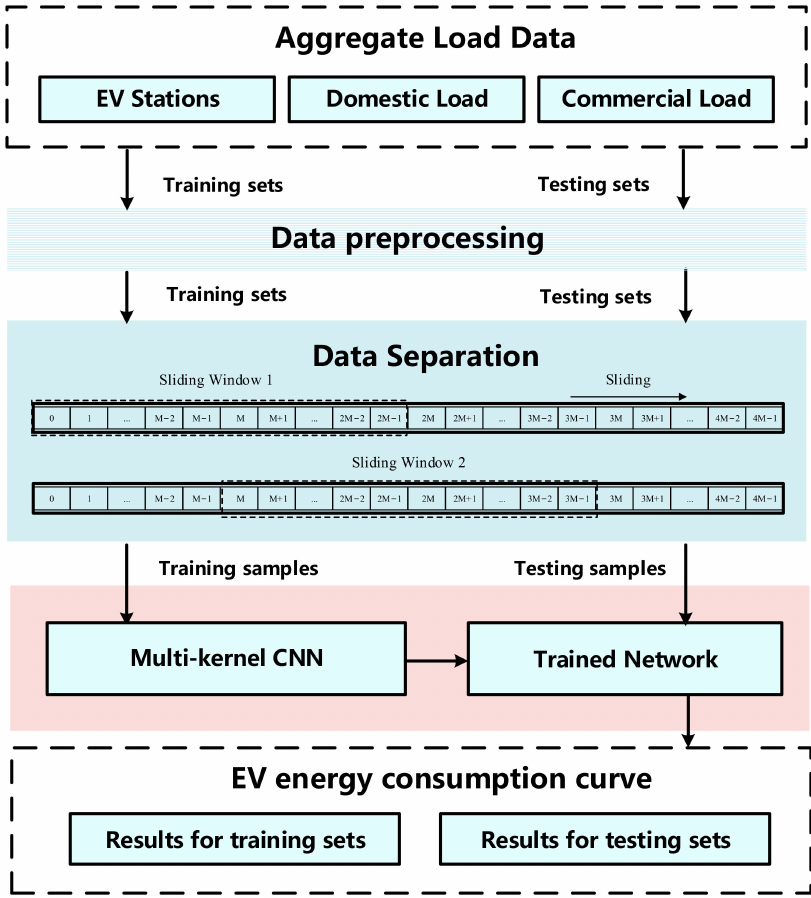
Figure 4. Overall Framework of The Proposed NILM